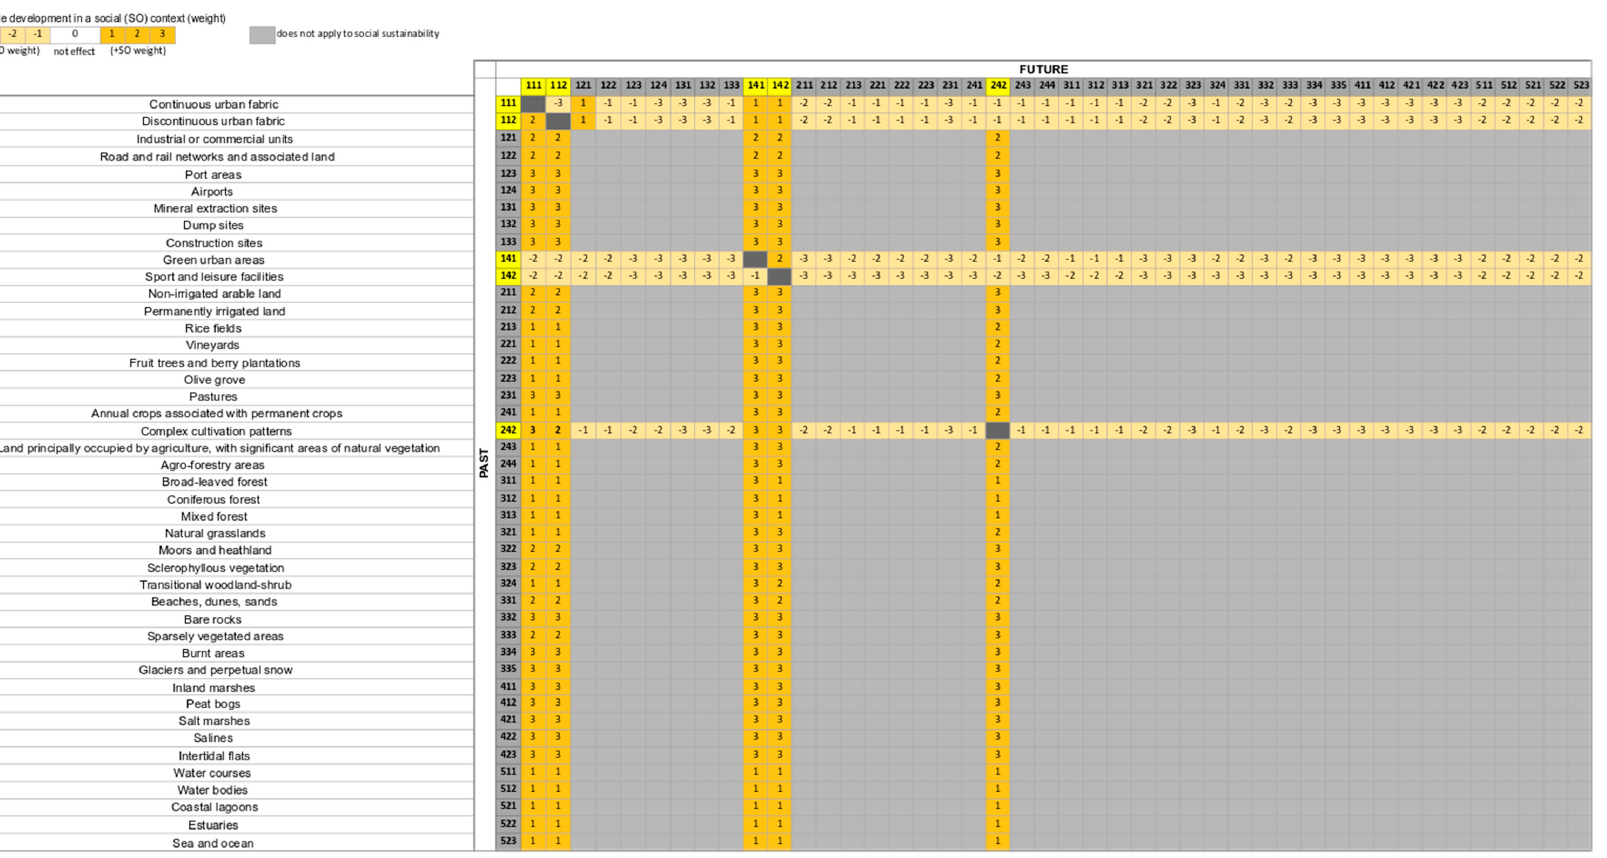
Figure A2 . Land use change assessment matrix in the social aspect Figure A2. Land use change assessment matrix in the social